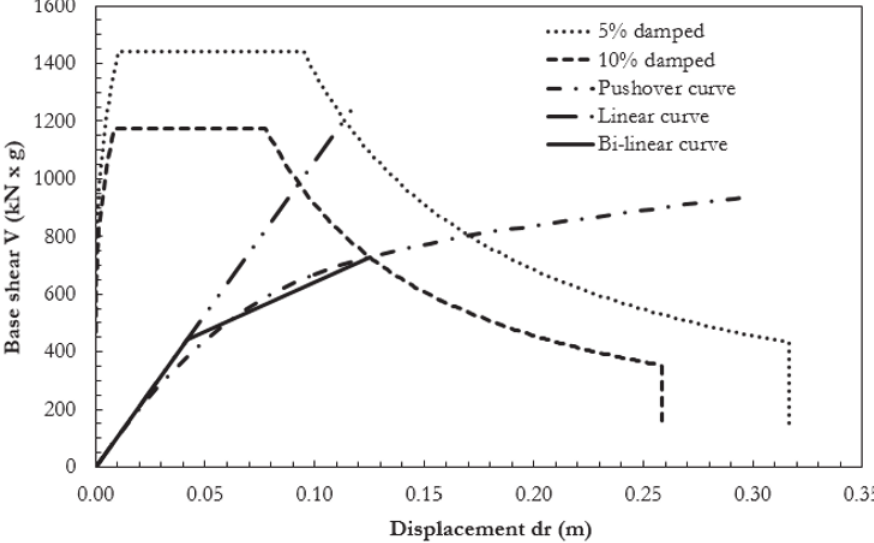
Response spectra, linear curve, bi-linear curve and pushover curve. The pushover analysis refers to the second mode on the x direction for K’ = 1.5 K. The maximum allowed displacement is 12.54 cm (intersection between pushover curve and response spectrum for 10%